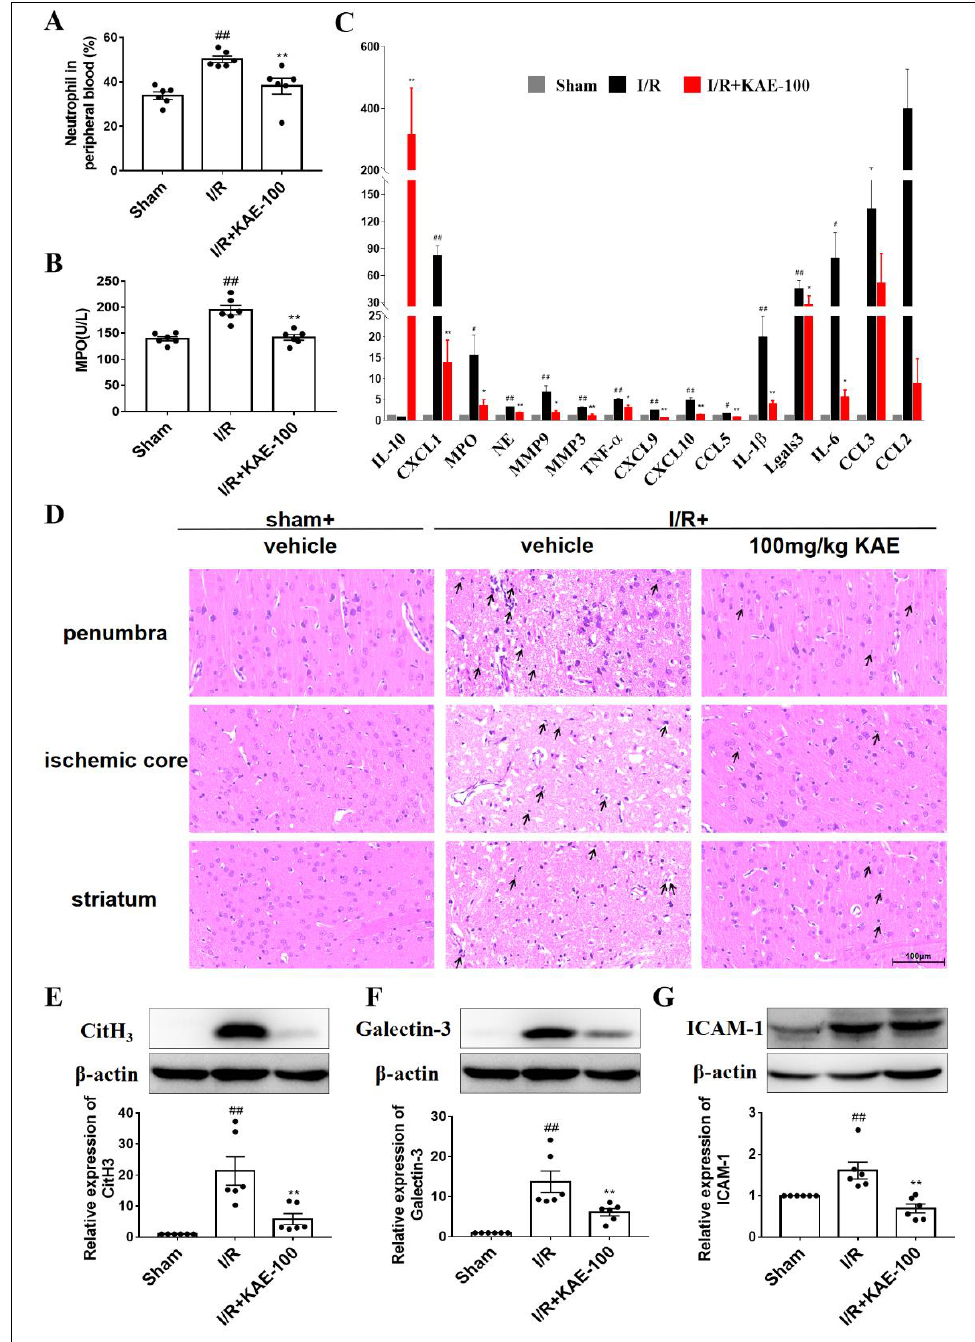
Figure 6. Effect of kaempferol on activation, aggregation and infiltration of neutrophils in rats on day 3 after cerebral I/R. ( A ) Neutrophil count in the peripheral blood was detected by Blood Analyzer. ( B ) MPO activity in serum was detected by ELISA kit. ( C ) Transcription levels of protease, chemokines and inflammatory factors released by neutrophils were detected by RT-PCR ( n = 6). ( D ) Representative images of HE staining in penumbra, ischemic core and striatum. 400 × magnification and scale bar = 100 µ m. Black arrows indicate neutrophils ( n = 4). Expression levels of neutrophil related proteins ( E ) CitH3, ( F ) Galectin-3 and ( G ) ICAM-1 in ischemic cortex were detected by Western blotting. Values are expressed as mean ± SEM ( n = 6). # p < 0.05, ## p < 0.01 vs. Sham group; * p < 0.05, ** p < 0.01 vs. I/R group. KAE: